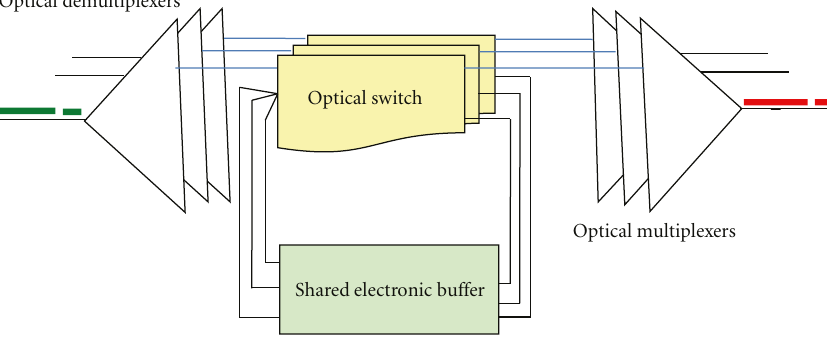
Figure 1: Optoelectronic